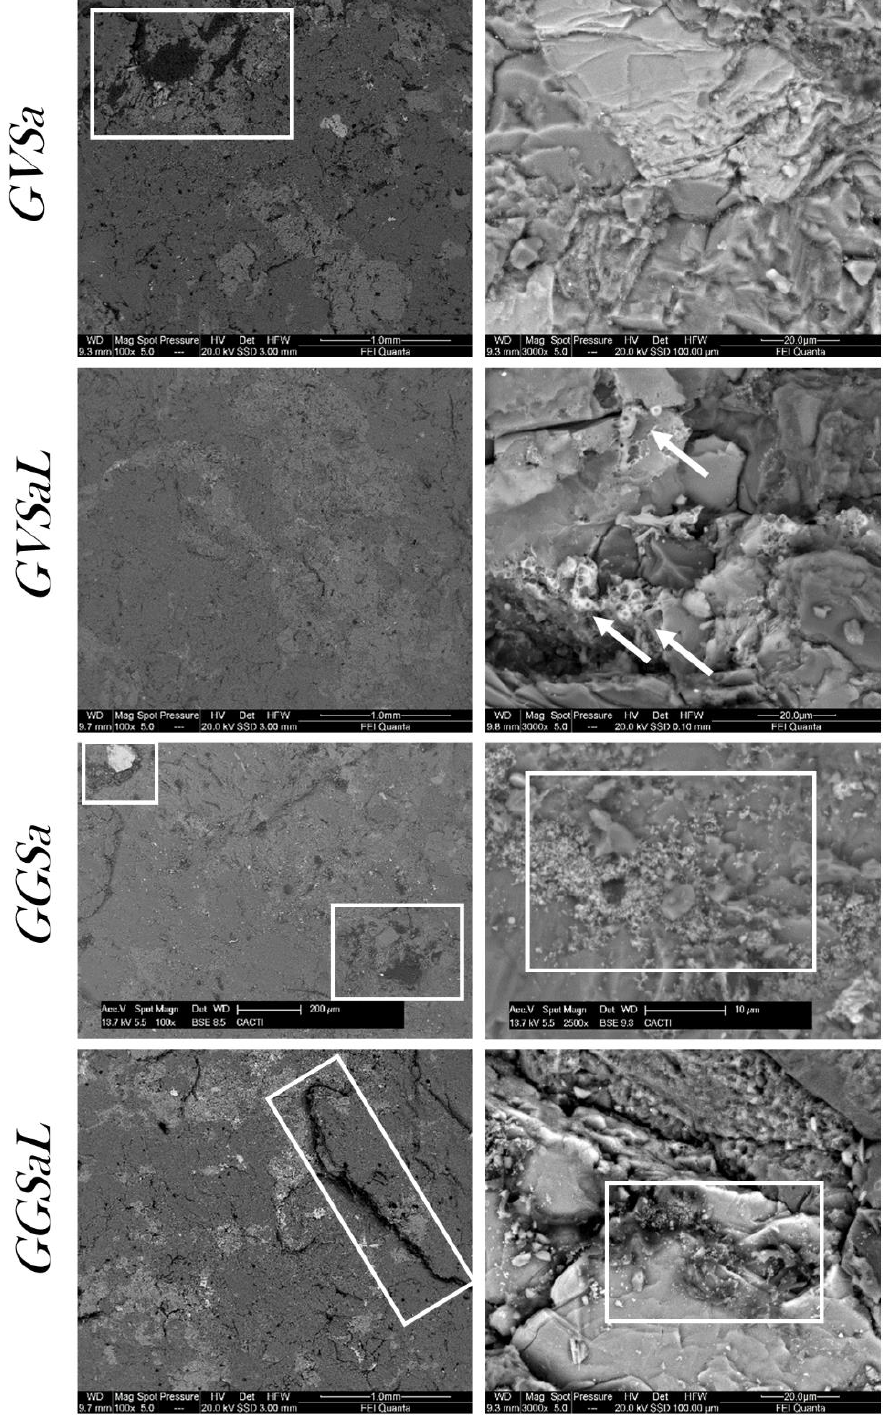
Figure 8. Scanning electron microscopy (SEM) micrographs of the gneiss surfaces after the application of the cleaning methods tested. Check Table 3 for sample labels.